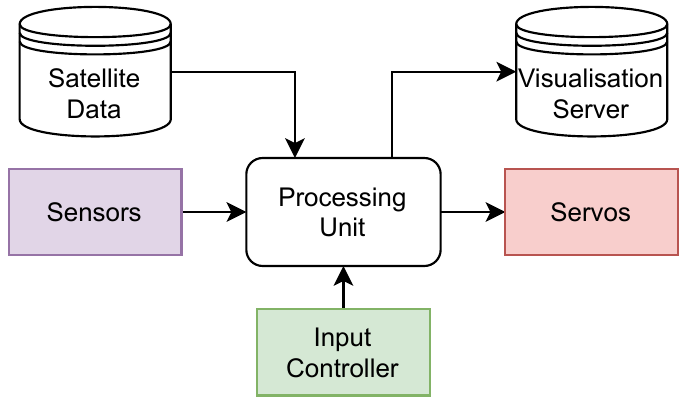
Figure 2. A simple outline of the proposed ‘TrackInk’ framework and its major